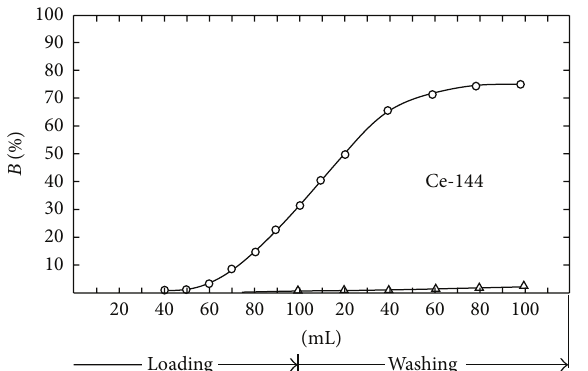
Figure 7: Breakthrough of cerium during the loading and washing on hydrated MnO 2 column from hydrogen-carbonate/carbonate containing solution: HCO 3− /CO 3−2 , ratio: 95/5, total molarity: 1M, cerium-concentration: 1mg/L, U-concentration: 35g/L, column inner diameter: 9.7 mm, bed volume: 5.5 mL, adsorber weight: 5.5 g MnO 2 , and loading speed: 30 cv/h. Ce-141 was added to the loading solution as a radioactive indicator.